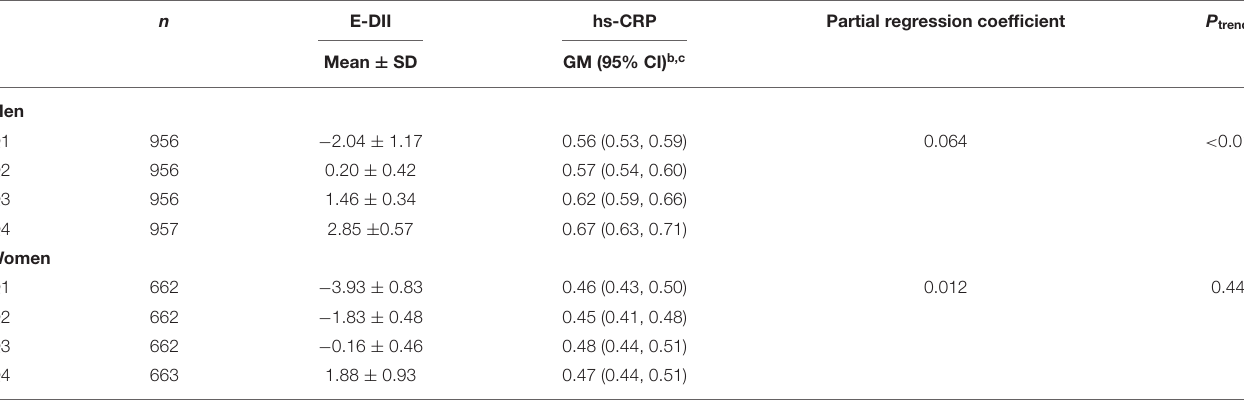
TABLE 3 | Adjusted geometric mean and 95% confidence interval of high-sensitivity C-reactive protein (hs-CRP) concentration in serum (mg/L) according to quartile of energy-adjusted dietary inflammatory index (E-DII) a .